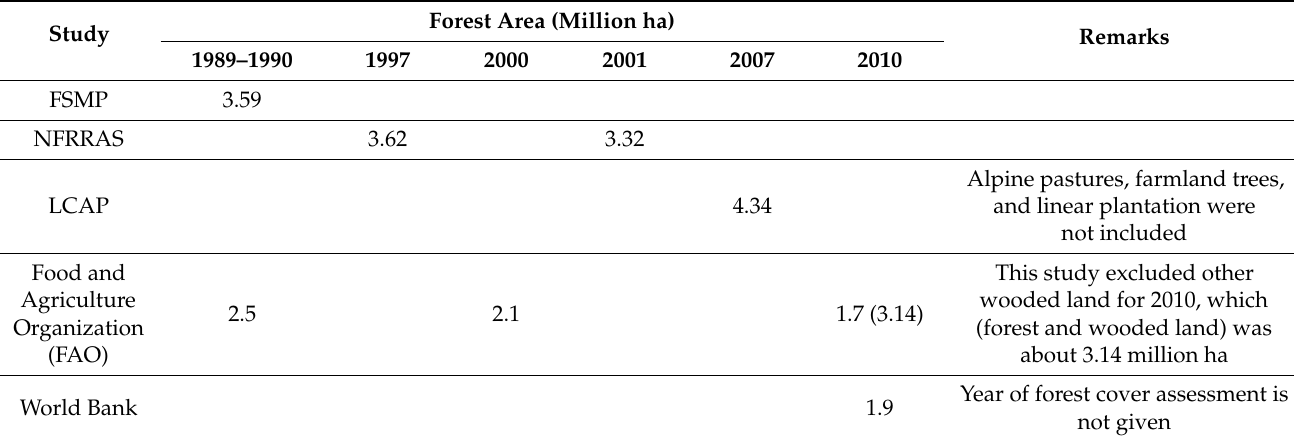
Table 2. Values for Pakistan forest cover from different